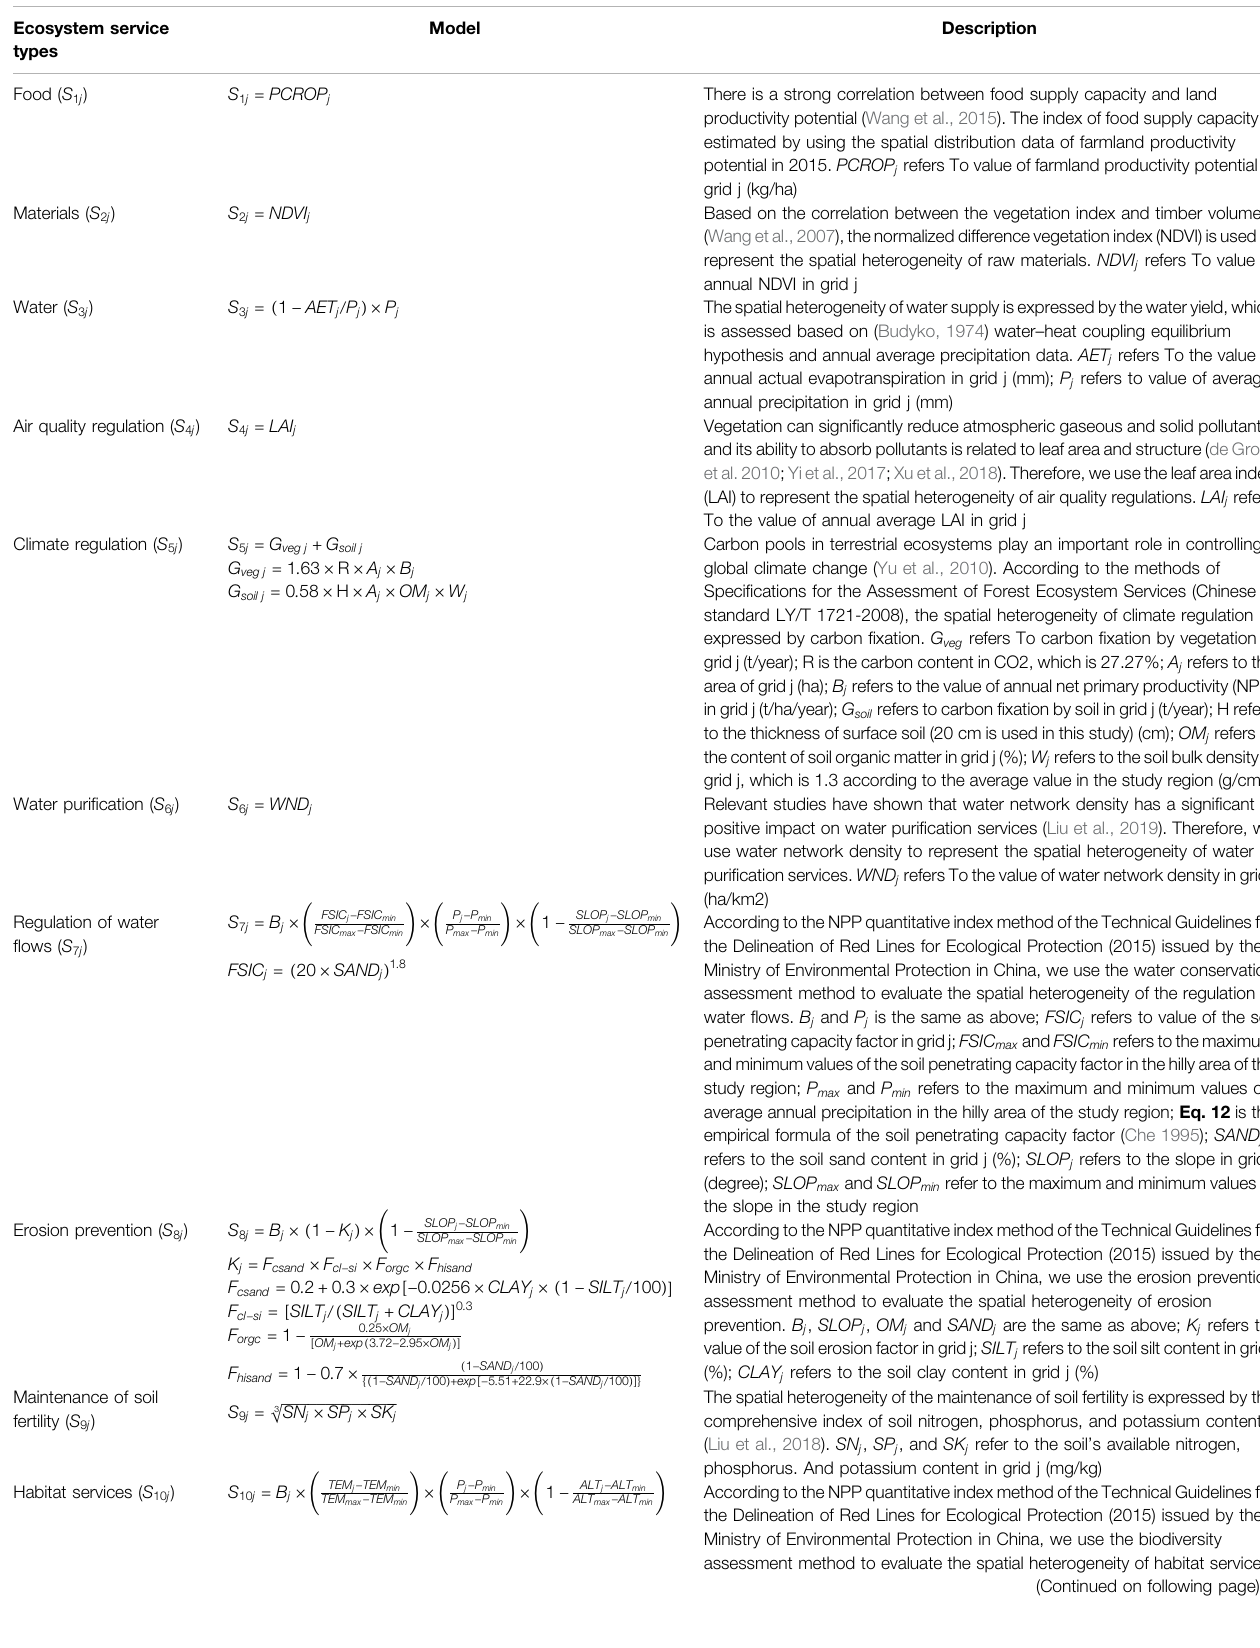
TABLE 2 | Spatial heterogeneity index model of the supply of 11 ecosystem services. Ecosystem service